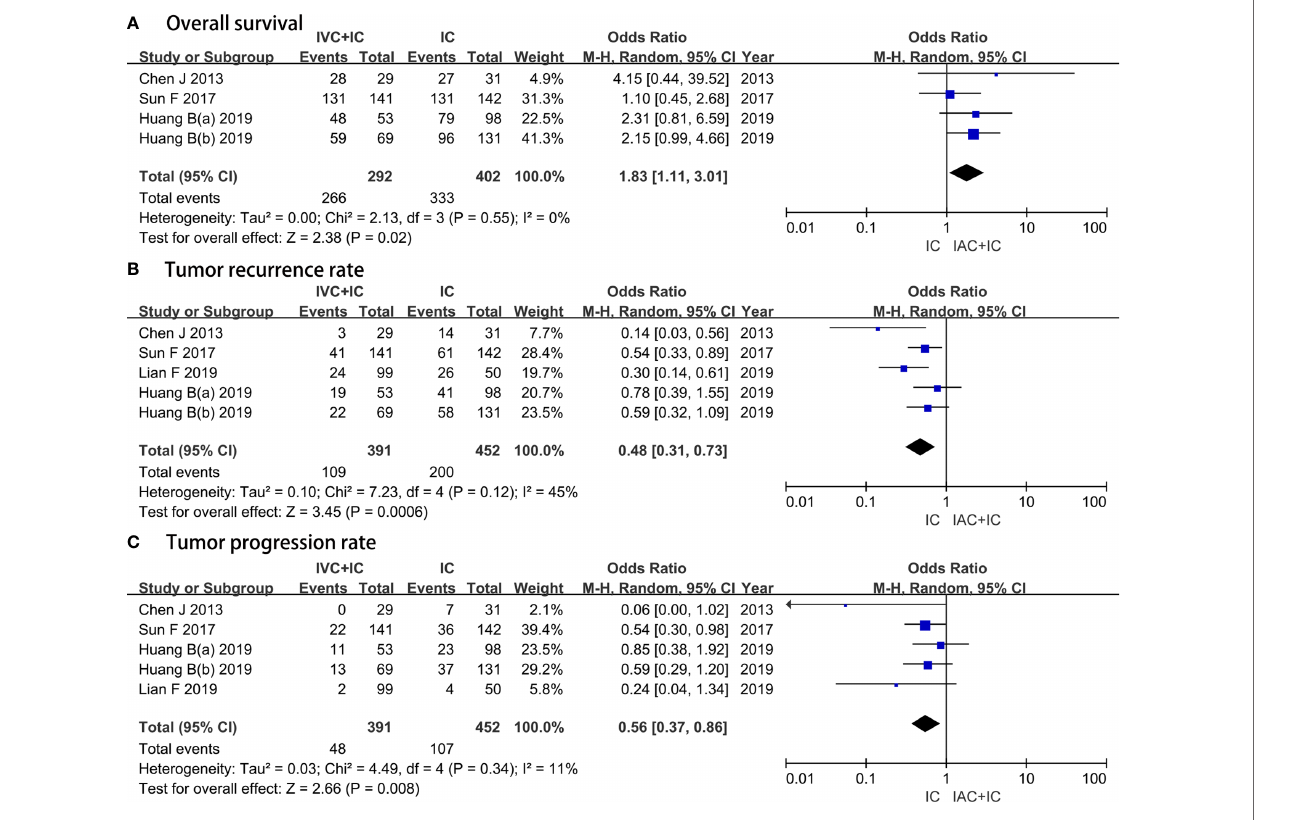
FIGURE 3 | Forest plots showing the result of (A) overall survival, (B) tumor recurrence rate and (C) tumor progression rate. M – H, Mantel – Haenszel; CI, con fi dence interval; df, degrees of